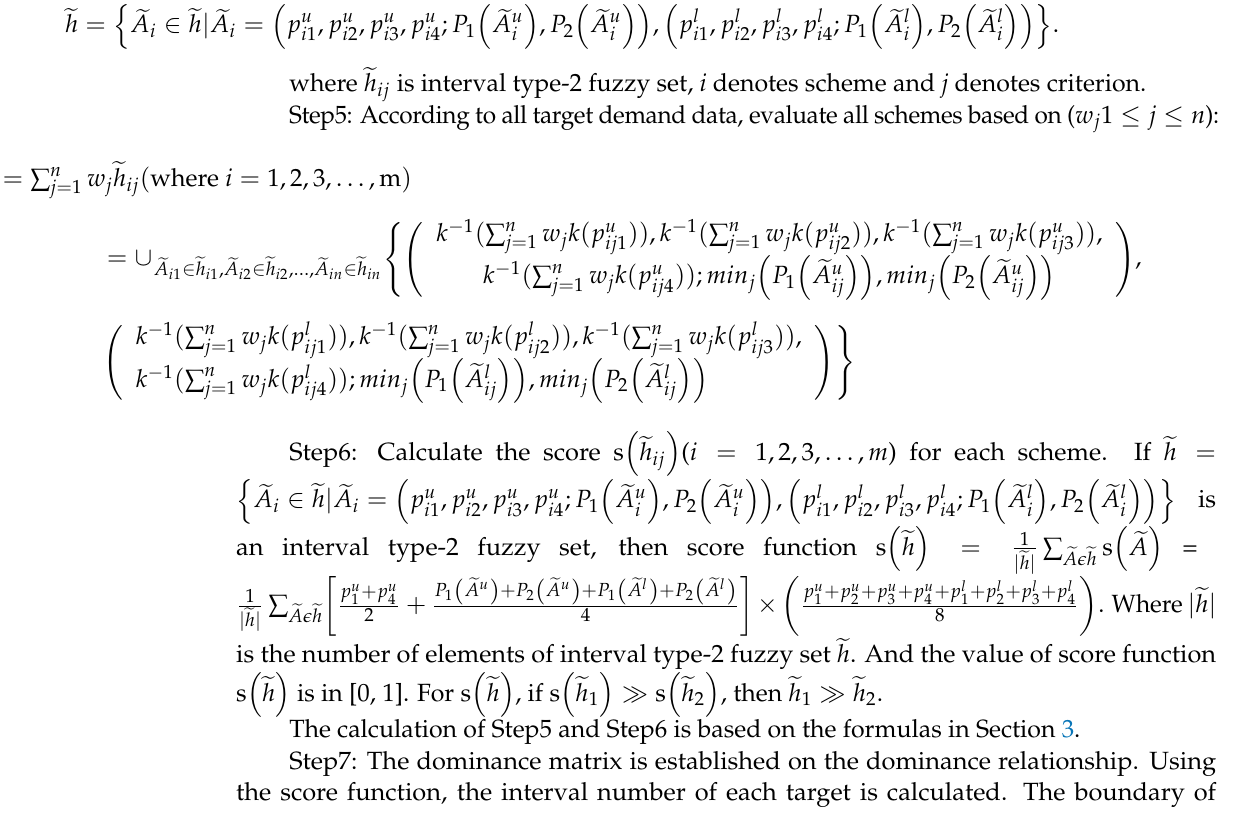
From Table 1, the data given by experts can be expressed by interval type-2 fuzzy